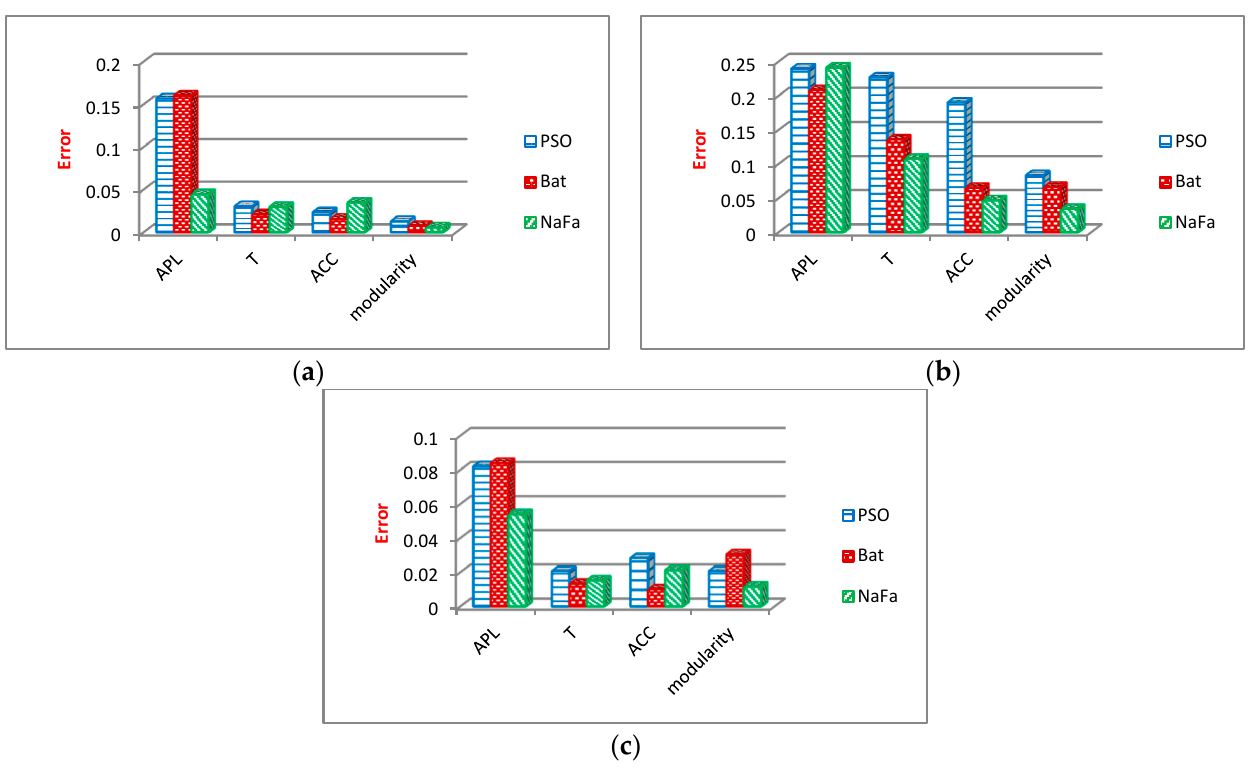
( b ) netscience, and ( c ) power grid.